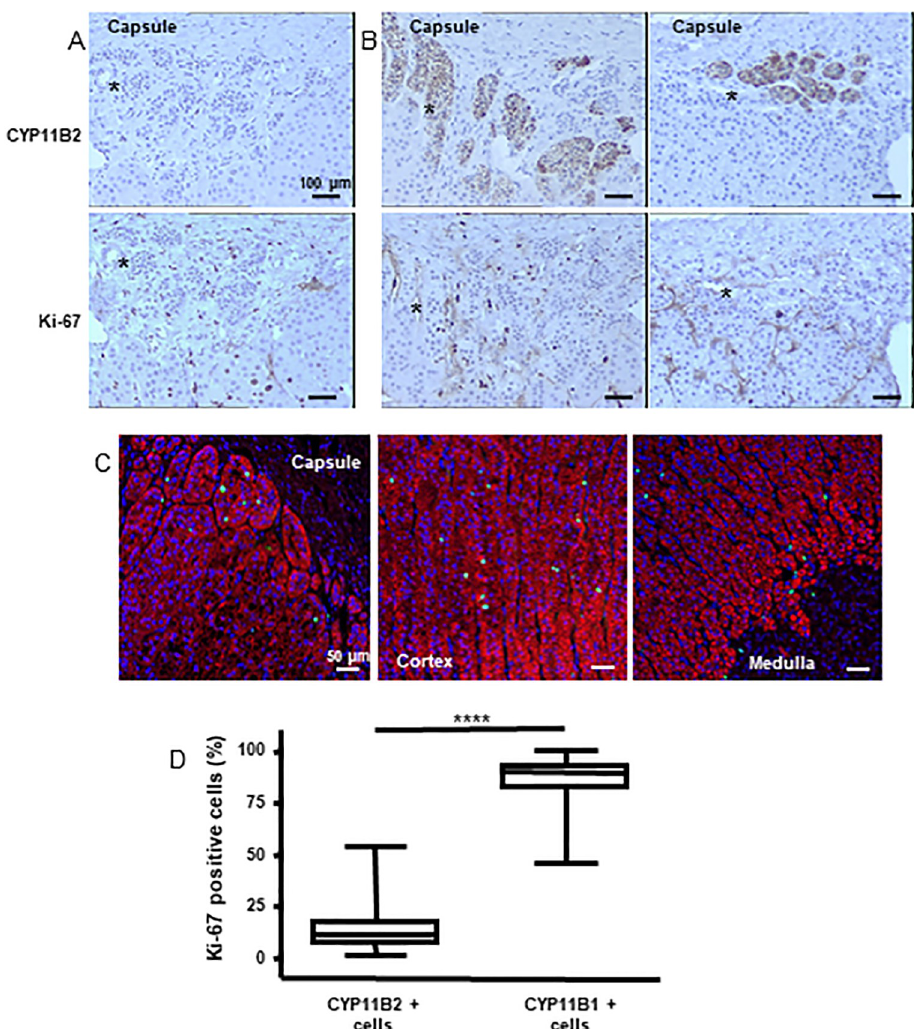
expressing cells ( ���� P <